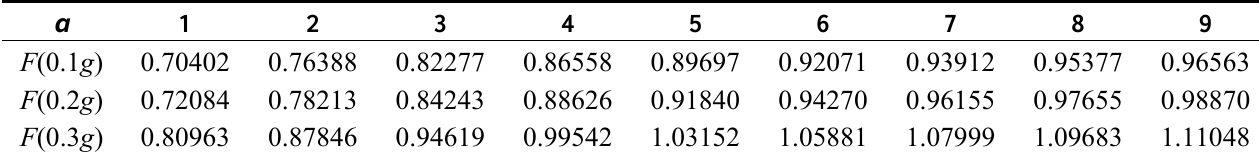
Table 1. Calculated F values for the GPA results and the Foreman model with different a values.